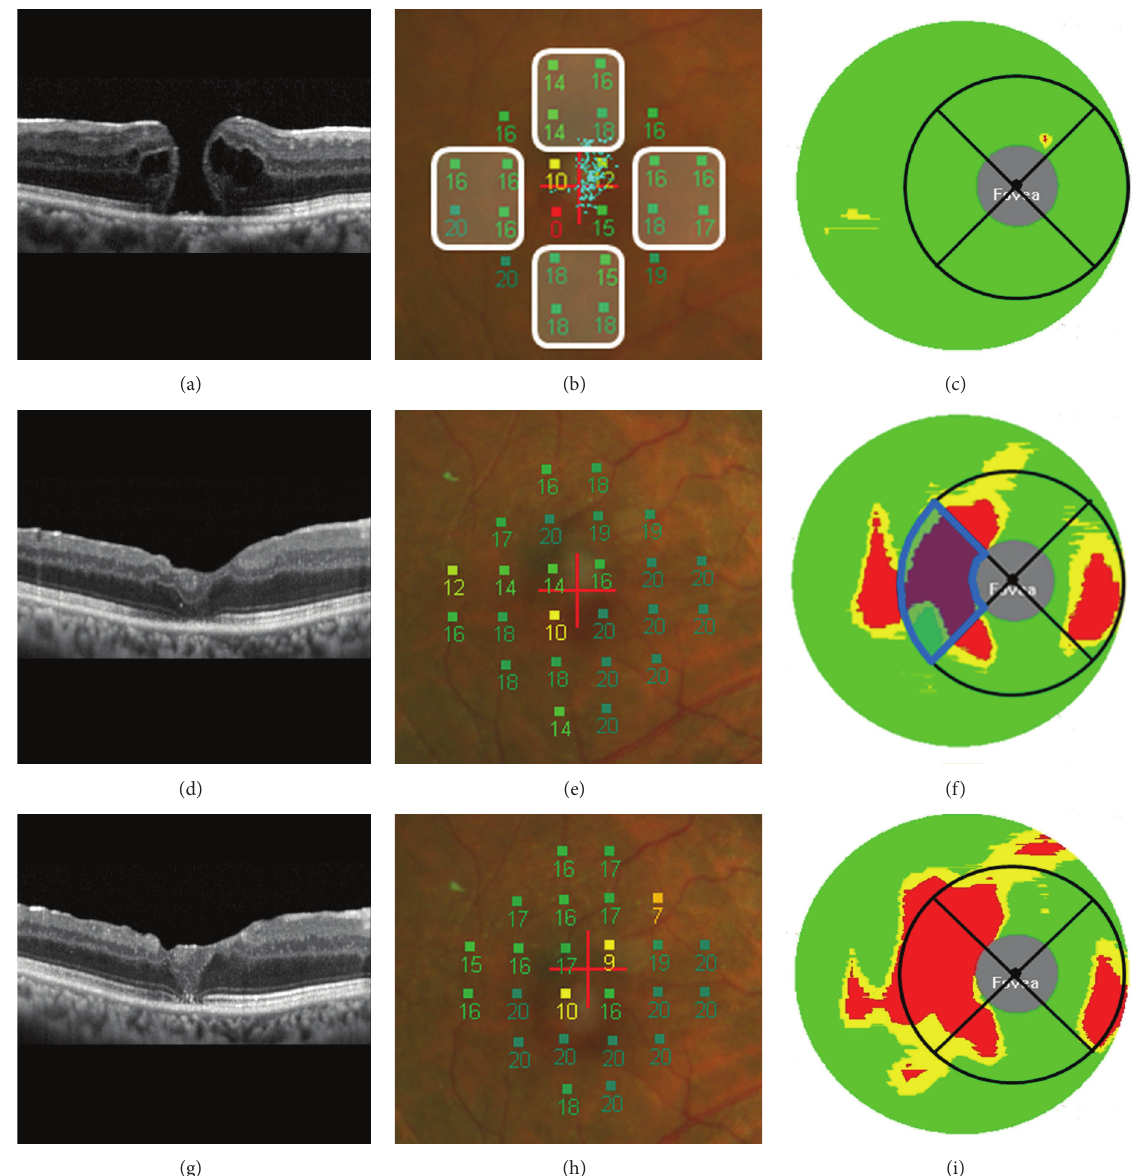
Figure 1: Right eye of a 67-year-old Japanese man with a macular hole (MH) treated by pars plana vitrectomy with ILM peeling. (a) Vertical OCT scan showing stage 3 MH. The preoperative decimal BCVA was 0.3. (b) Regional retinal sensitivity measured by MP1 was determined by averaging 4 locations shown in each white square. The sensitivity was 15.5 dB at the superior, 17.3 dB at the inferior, 17.0dB at the temporal, and 16.8 dB at the nasal quadrants. (c) Ganglion cell complex (GCC) color-coded thickness map determined by SD-OCT of the preoperative eye. There are no red areas which would indicate that there are no areas thinner than that of the normative data. The diameter of the entire map is 6mm and that of the inner ring is 4mm. (d) Three months after the surgery, the horizontal OCT image shows that the MH is closed and the decimal BCVA has improved to 0.9. (e) Retinal sensitivity was 18.3dB at superior, 18.0 dB at the inferior, 15.0 dB at the temporal, and 20.0 dB at the nasal area. (f) GCC thickness map 3 months after surgery. The percentage area of thin GCC (red) in one sector (blue) was calculated using software NIH ImageJ. In this case, it is 60.8% at the temporal quadrant. Similarly, the area of thin GCC was 14.8% at superior, 11.1% at inferior, and 26.9% at the nasal quadrant. (g) Six months after the surgery, the horizontal OCT showed MH closed, and the decimal BCVA was improved to 1.2. (h) The retinal sensitivity was 16.5 dB at the superior, 19.8 dB at the inferior, 16.8dB at the temporal, and 20.0 dB at the nasal retina. (i) The percentage of thin GCC was 26.5% at the superior, 16.4% at the inferior, 83.5% at the temporal, and 21.2% at the inferior